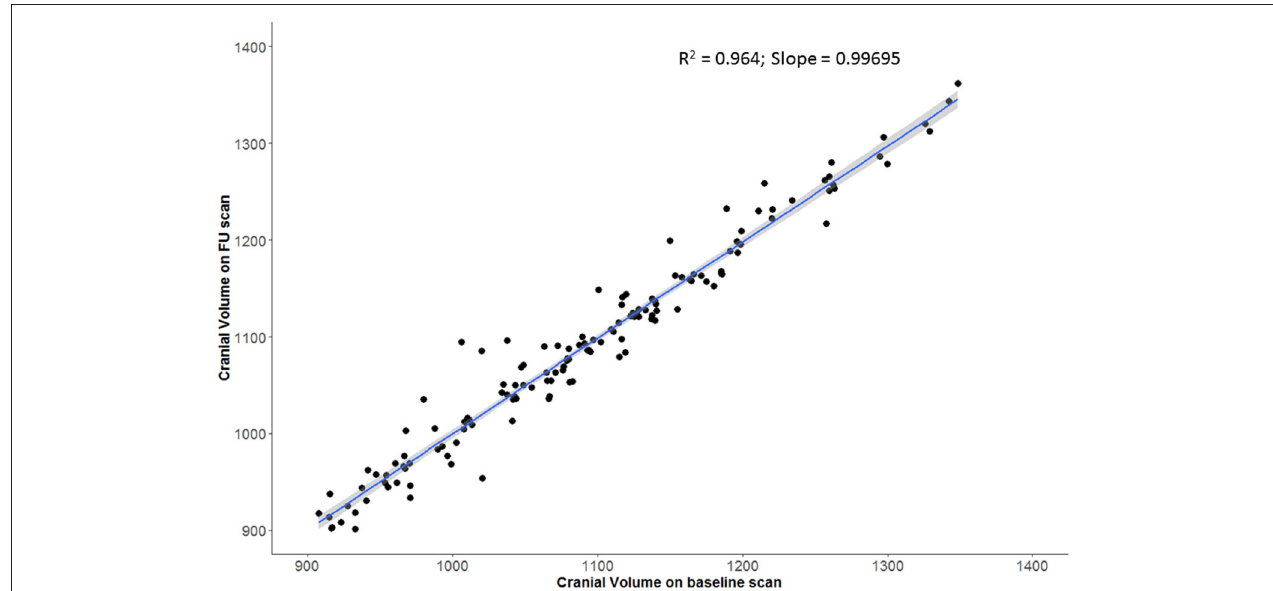
FIGURE 3 | Strong agreement of registered cranial volumes on baseline and follow-up scans.